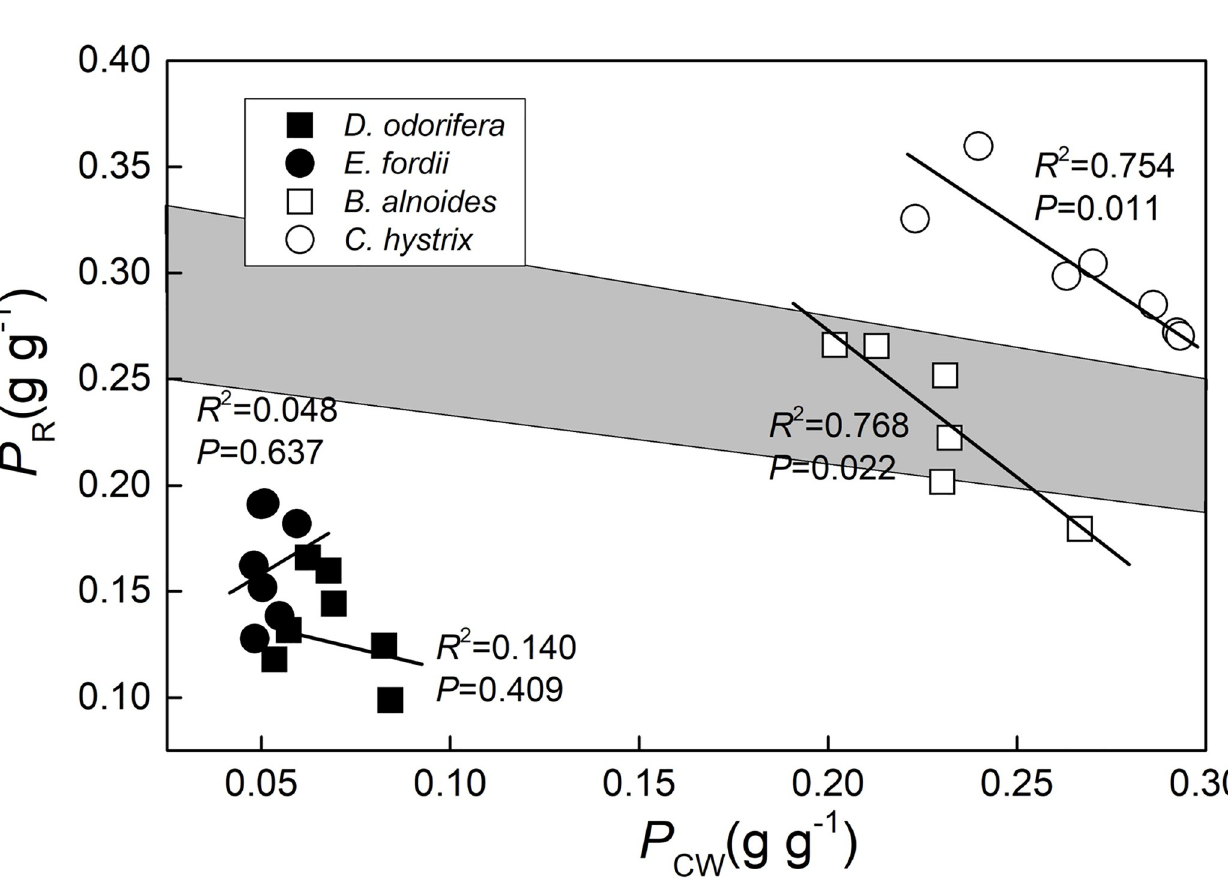
Fig 3. Regression analysis of the fraction of leaf N allocated to the cell wall ( P CW ) with leaf N allocated to Rubisco ( P R ) in four species seedling leaves. The determination coefficient ( R 2 ) and P -value were also shown. The shaded zone was drawn according to this hypothesis: when P CW was 0.300 g g –1 , the rest (0.700 g g –1 ) were soluble and thylakoid protein, Rubisco represented one quarter to one-third of the N in soluble and thylakoid protein, P R valued 0.175–0.233 g g –1 (right side of shaded zone). When P CW was valued 0.000 g g –1 in limiting case (does not exist in reality), all the rest (1.000 g g –1 ) were soluble and thylakoid protein, P R valued 0.250–0.333 g g –1 (left side of shaded zone). For more information see Harrison et al . [21]. The lines fitted separately for four species were significantly different ( P < 0.05) according to the result of a one-way ANCOVA with P R as a dependent variable, tree species as fixed factors, and P CW as a